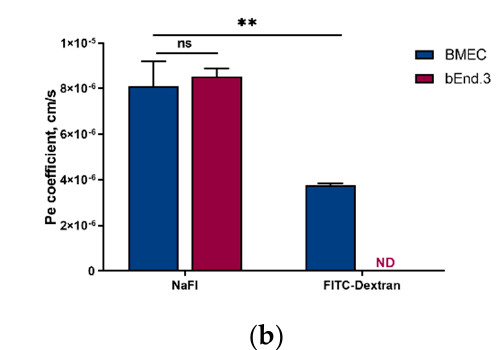
12 of 22 Figure 2. Effect of puromycin on BMEC (blue) and bEnd.3 cell (red) viability. Data were analyzed using a 2-way ANOVA test (**** p < 0.0001). Points represent the average cell viability ± SD ( n = 6). 3.2. Monolayer Models and Subsequent Characterization 3.2.1. TEER and Pe of Fluorescent Markers Primary BMEC and bEnd.3 cells were turned into in vitro models when cultured on porous polymeric membranes separating two compartments (Transwell ® plates). Cells confluence was observed on day 7. Two techniques were used to compare the effectiveness of the BMEC and the bEnd.3 models to form a tight monolayer. First, TEER calculations were performed on days 2, 3, 4. On day 7, monolayer tightness was evaluated using TEER calculation and, additionally, by measuring the permeability of two fluorescent markers. Both these markers are hydrophilic molecules with different sizes (NaFl: 360 Da, FITC-D: 150 kDa) used to evaluate the paracellular permeability. TEER for the BMEC model showed 2-fold higher values compared to those calculated for the bEnd.3 model. This significant difference was observed from day 2 to 7 (Figure 3a). Thus, on day 7, the primary model displayed a TEER value of 80 ± 10 Ω × cm 2 while the bEnd.3 model showed a